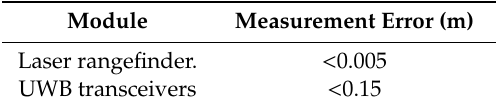
Table 2. Measurement parameters of modules.